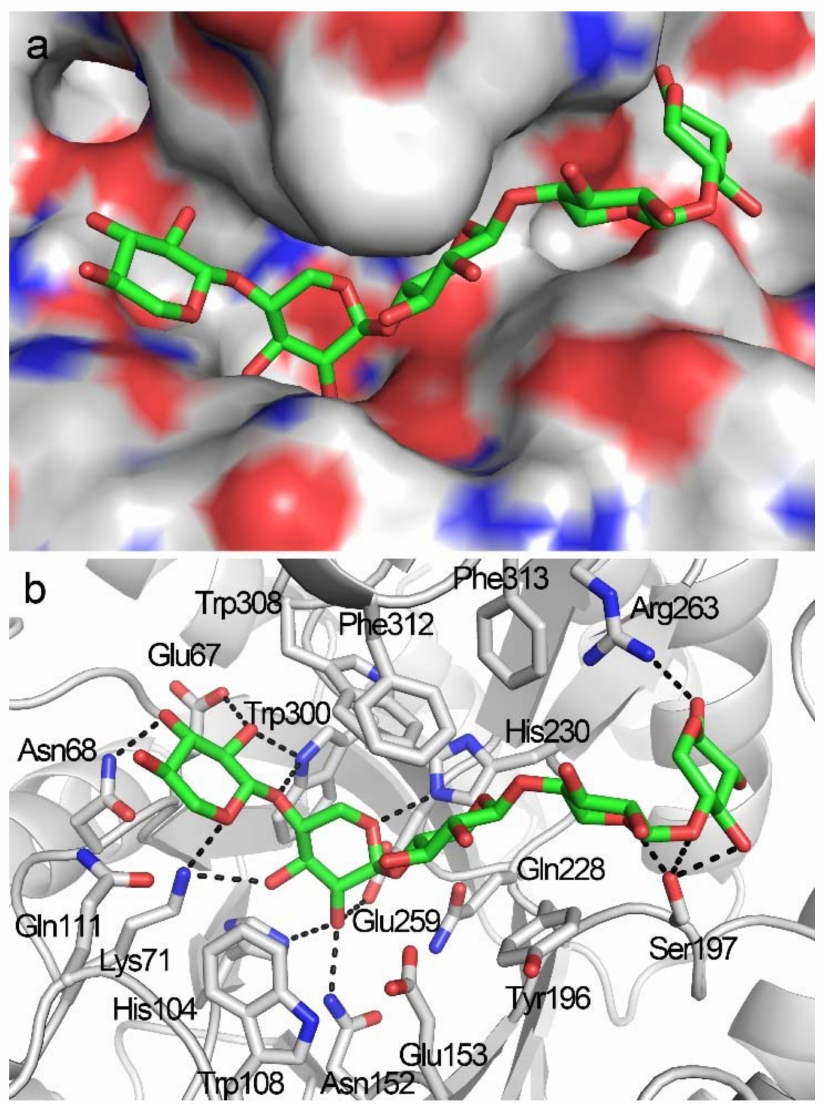
Figure 6. Docking structures of TmxB in complex with X5. ( a ) Binding position of X5 in the active-site cleft of TmxB. ( b ) Interaction details between TmxB and X5. The putative hydrogen bonds are indicated by black dashes. The carbon atoms from amino acids and X5 molecule are shown in gray and green,